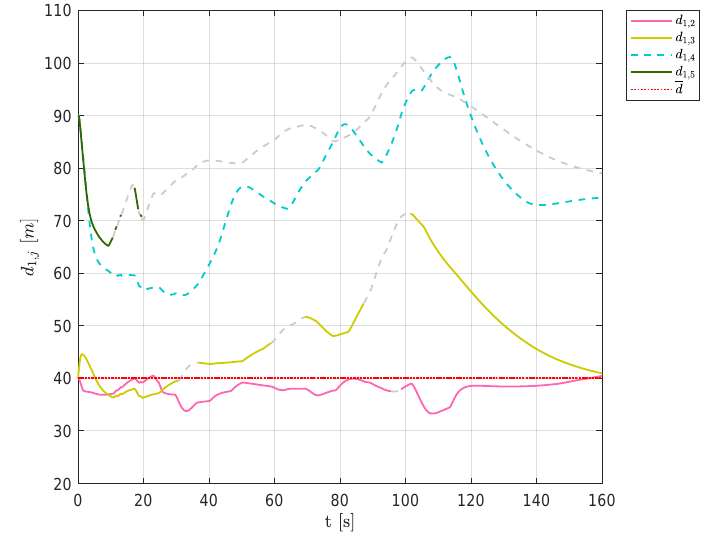
Figure 13. Scenario #1—five aircraft: distances between UAV 1 and the other swarm vehicles. Solid lines are used for visible aircraft, dashed gray lines are employed whenever they are no longer visible, whereas dashed colored lines are used for never visible UAVs. The desired distance is highlighted using a dotted red